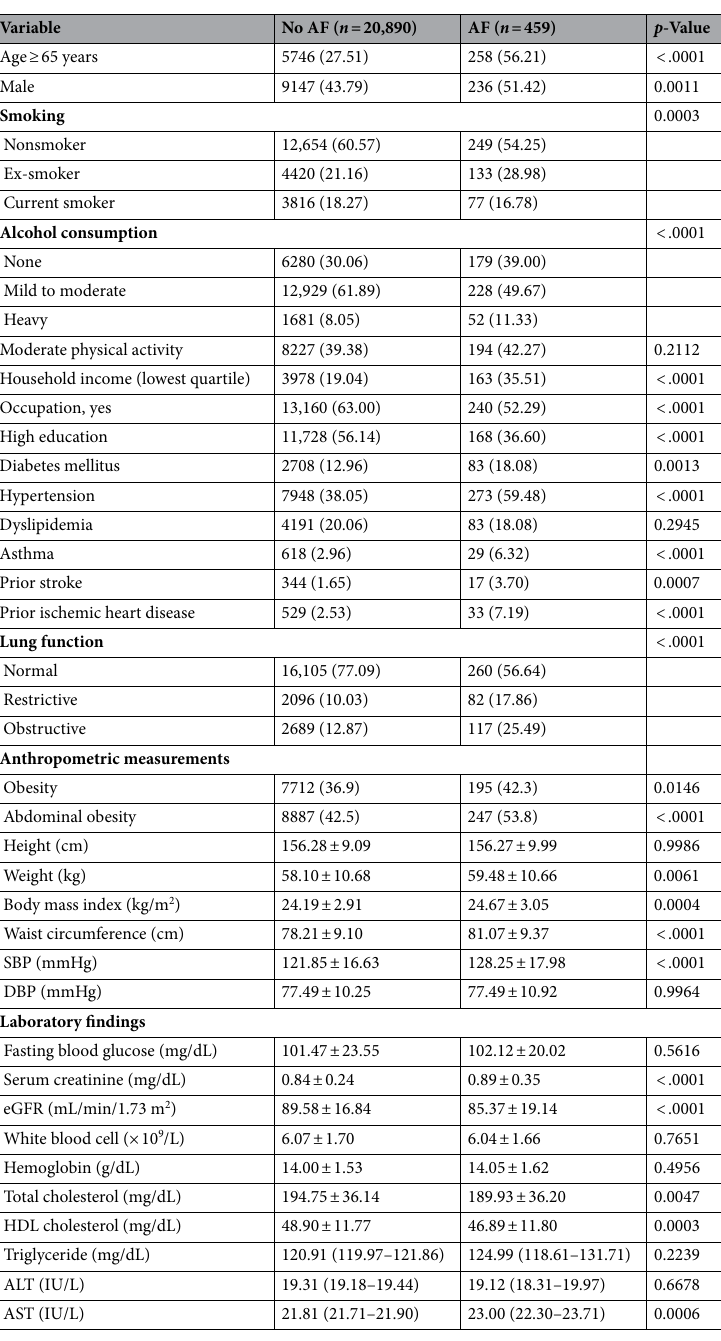
eGFR, estimated glomerular filtration rate; HDL, high density lipoprotein; AST, aspartate transaminase; ALT, alanine